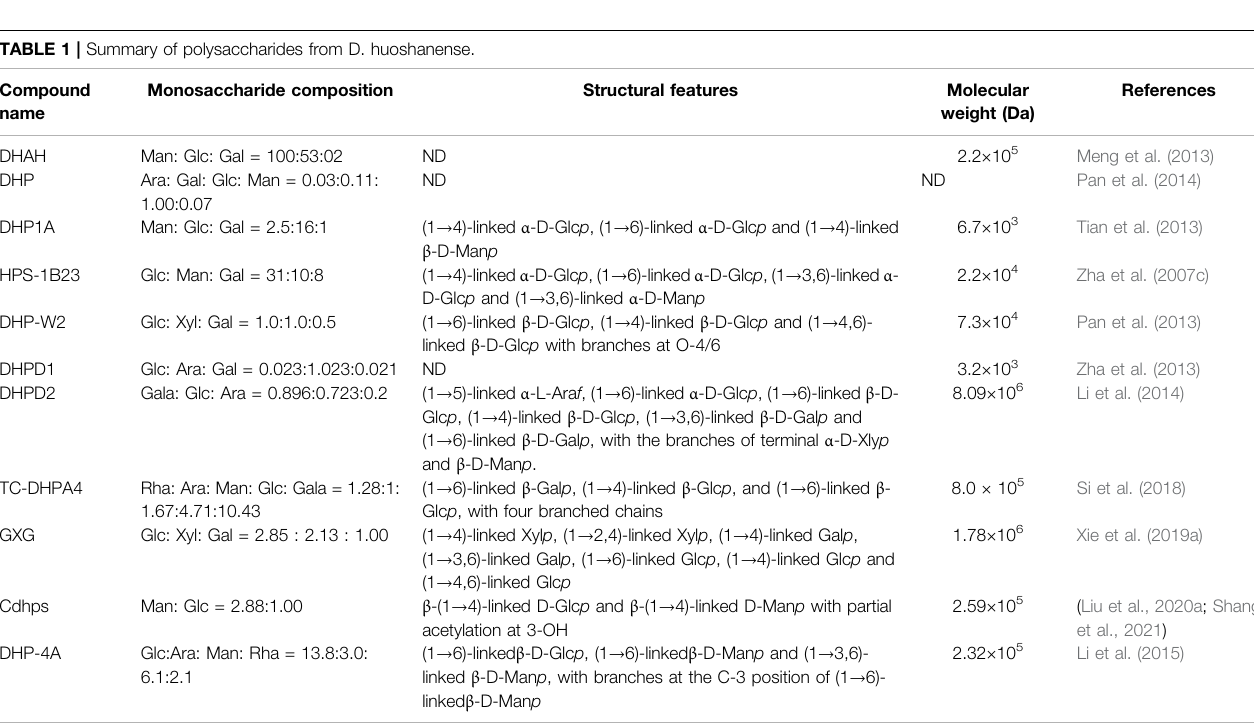
TABLE 1 | Summary of polysaccharides from D.